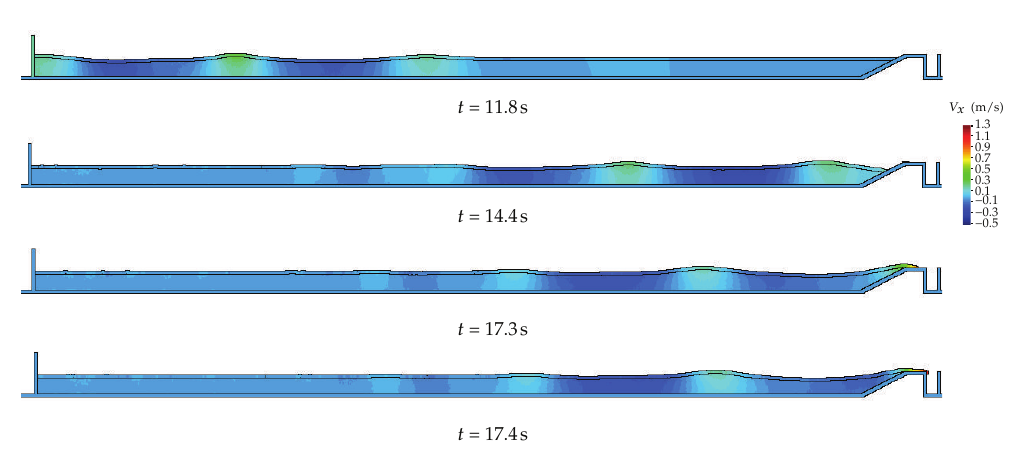
Figure 3: Horizontal velocities (cid:2) m/s (cid:3) along the flume for four di ff erent time steps and for wave case 1, H (cid:9) 0 . 06m and T (cid:9) 1 .